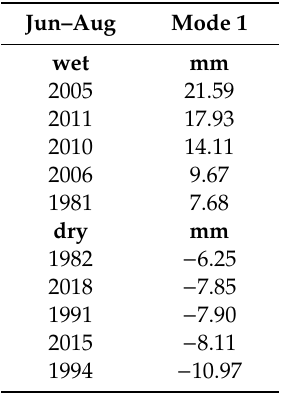
Table 2. Ranked Caribbean wet and dry seasons for SVD